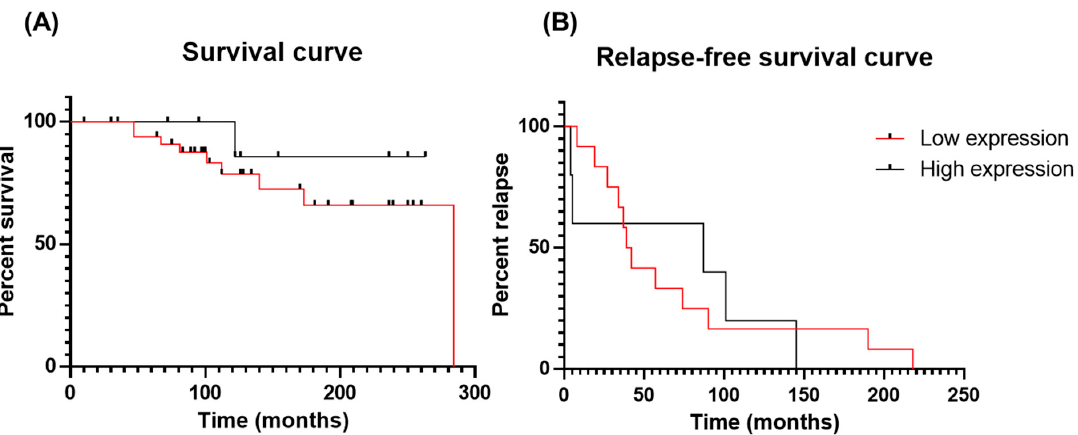
Figure 5. Impact of Gal-3 expression on PCa patient survival ( A ) ( p = 0.36) and relapse-free survival ( B ) ( p = 0.95).